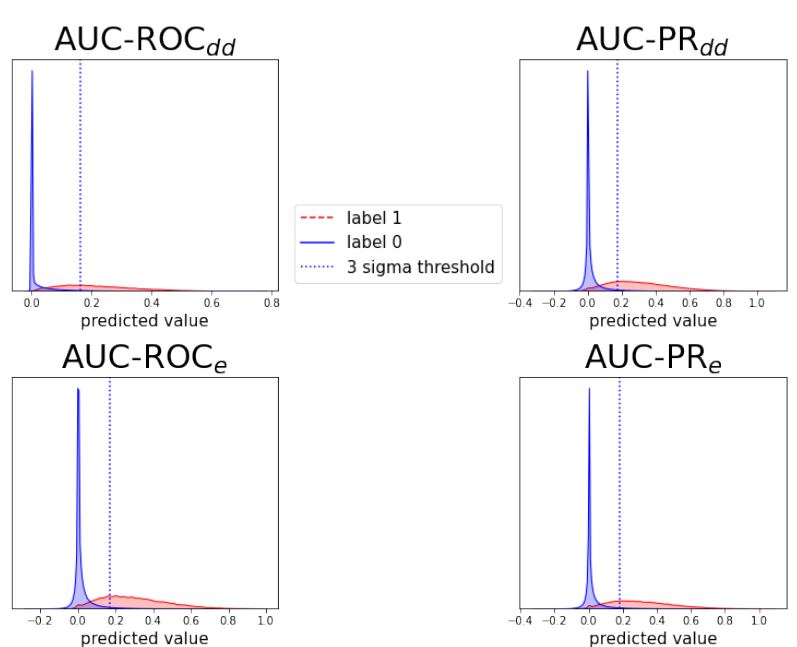
Figure A6. Individual prediction histograms of the model for task (cid:100) dde . The predictions for the ten test folds are pooled and plotted separately for the originally zero-labeled and one-labeled triplets. For zero-labeled triplets, a prediction peak near zero is found and a 3 σ -threshold is shown. Each of the panels shows the results of a model optimized for AUC-ROC or AUC-PR and evaluation scheme E dd or E e .